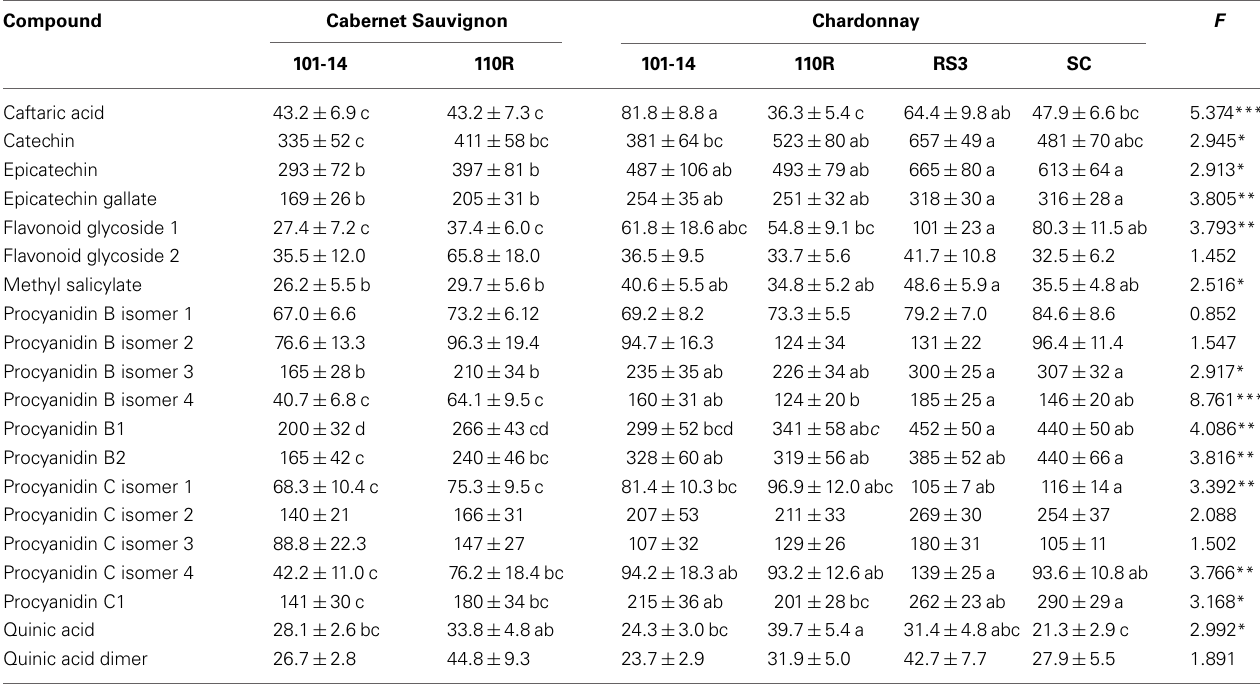
Table 4 | Mean ( ± SE) sap levels ( μ g/mL) of phenolic compounds from both non-infected and Xf-infected grapevines with different scion/rootstock combinations.